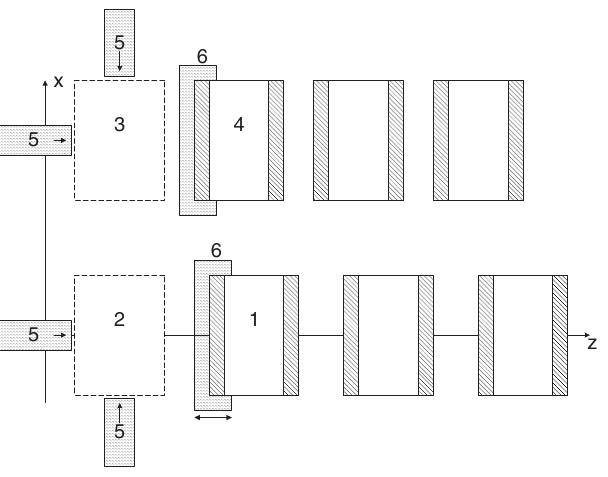
FIG. 5. One of the possible schemes of variation of the number of periods (top view). (1)–(4) Successive positions of the block being removed, (5) pushers, and (6) adjustable stops. The lower blocks are in the undulator, the upper ones in the cartridge for spare